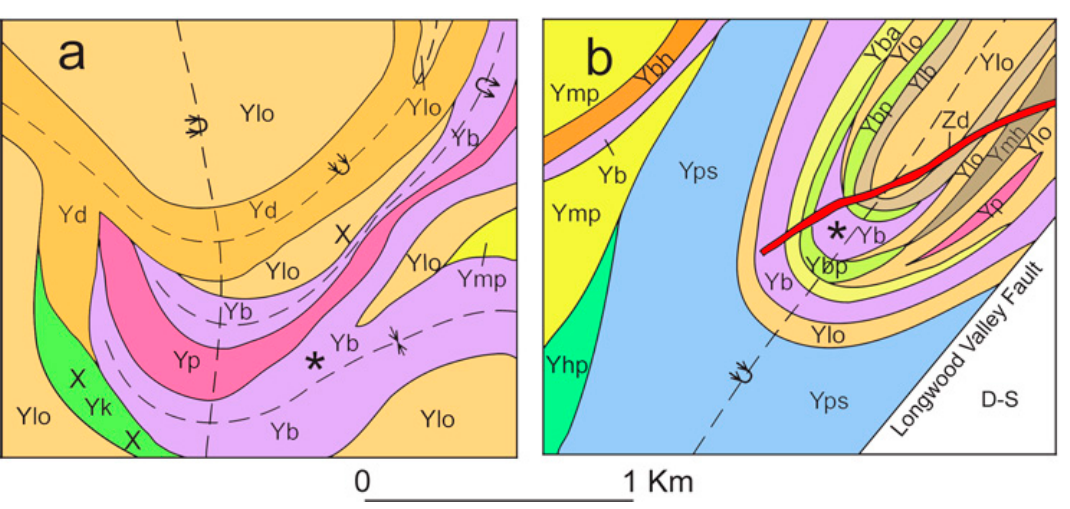
Figure 3. ( a ) Bedrock geology of the southeastern part of the Greenwood Lake 7.5-minute ( a ) Bedrock geology of the southeastern part of the Greenwood Lake quadrangle [16] showing geologic relationships at the Ringwood kornerupine location. ( b ) Bedrock geology of the western part of the Dover 7.5-minute quadrangle [17] showing geologic relationships at the Mase Mountain kornerupine + prismatine location. Abbreviations: asterisk, kornerupine location; X, Fe-Ti oxide deposit; Yb, biotite gneiss; Yp, pyroxene gneiss; Yk, rhyolite gneiss; Ymp, clinopyroxene-quartz-feldspar gneiss; Ylo, tonalite gneiss; Yd, diorite gneiss; Ybp and Yhp, meta- anorthosite gneiss; Yps, clinopyroxene syenite; Yba, microperthite alaskite; Ybh, hornblende granite; D-S, undivided Devonian and Silurian cover rocks. Dashed lines show trace of axial surface of folds that deform Ottawan metamorphic fabric. See Figure 1 for location of Figure 3a,b.